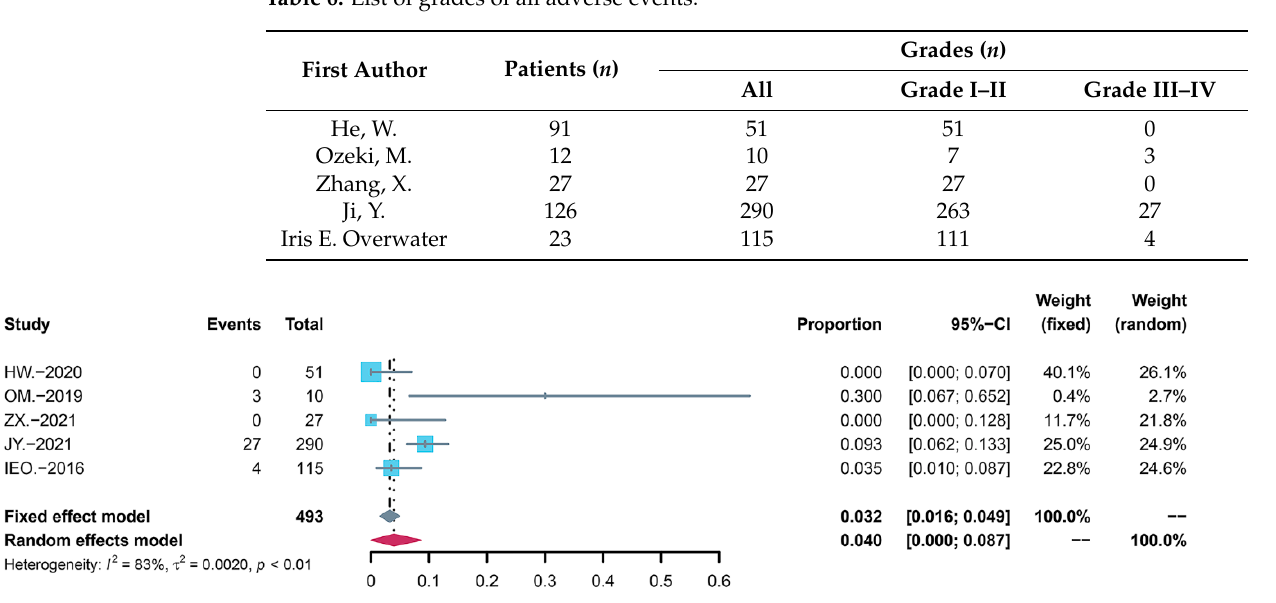
Table 6. List of grades of all adverse events.